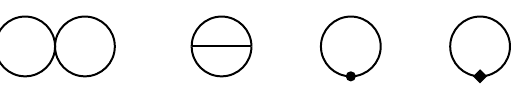
Figure 4 . Two-loop level diagrams for the effective potential in 4d perturbation theory. The last two diagrams comprise renormalisation and resummation counterterms with quadratic interactions,